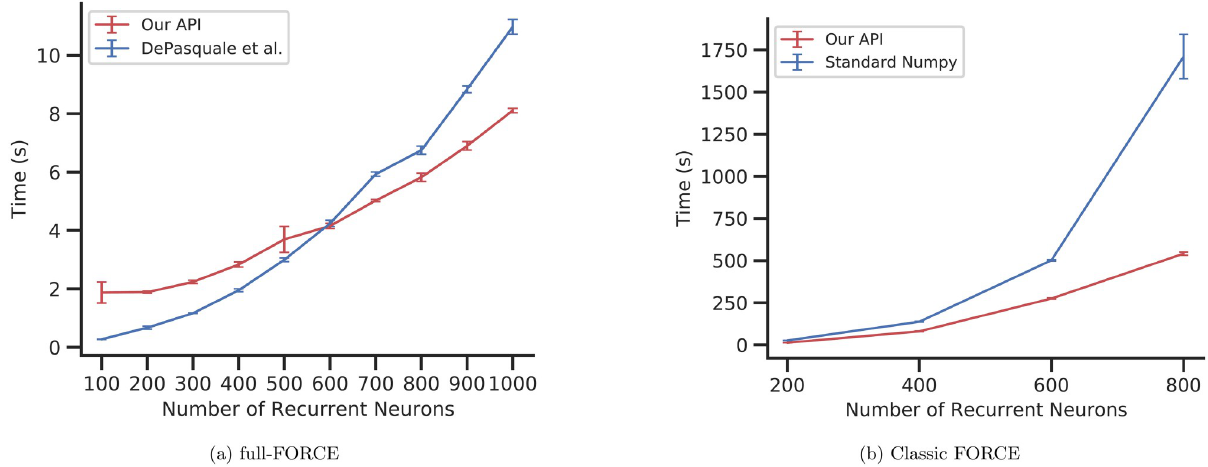
Fig 5. Runtime comparison using our API vs published/standard Python implementations. (A) full-FORCE (average across 10 epochs; error bars: standard deviation across 10 random initializations) (B) classic FORCE (average across 5 epochs; error bars: standard deviation across 5 random